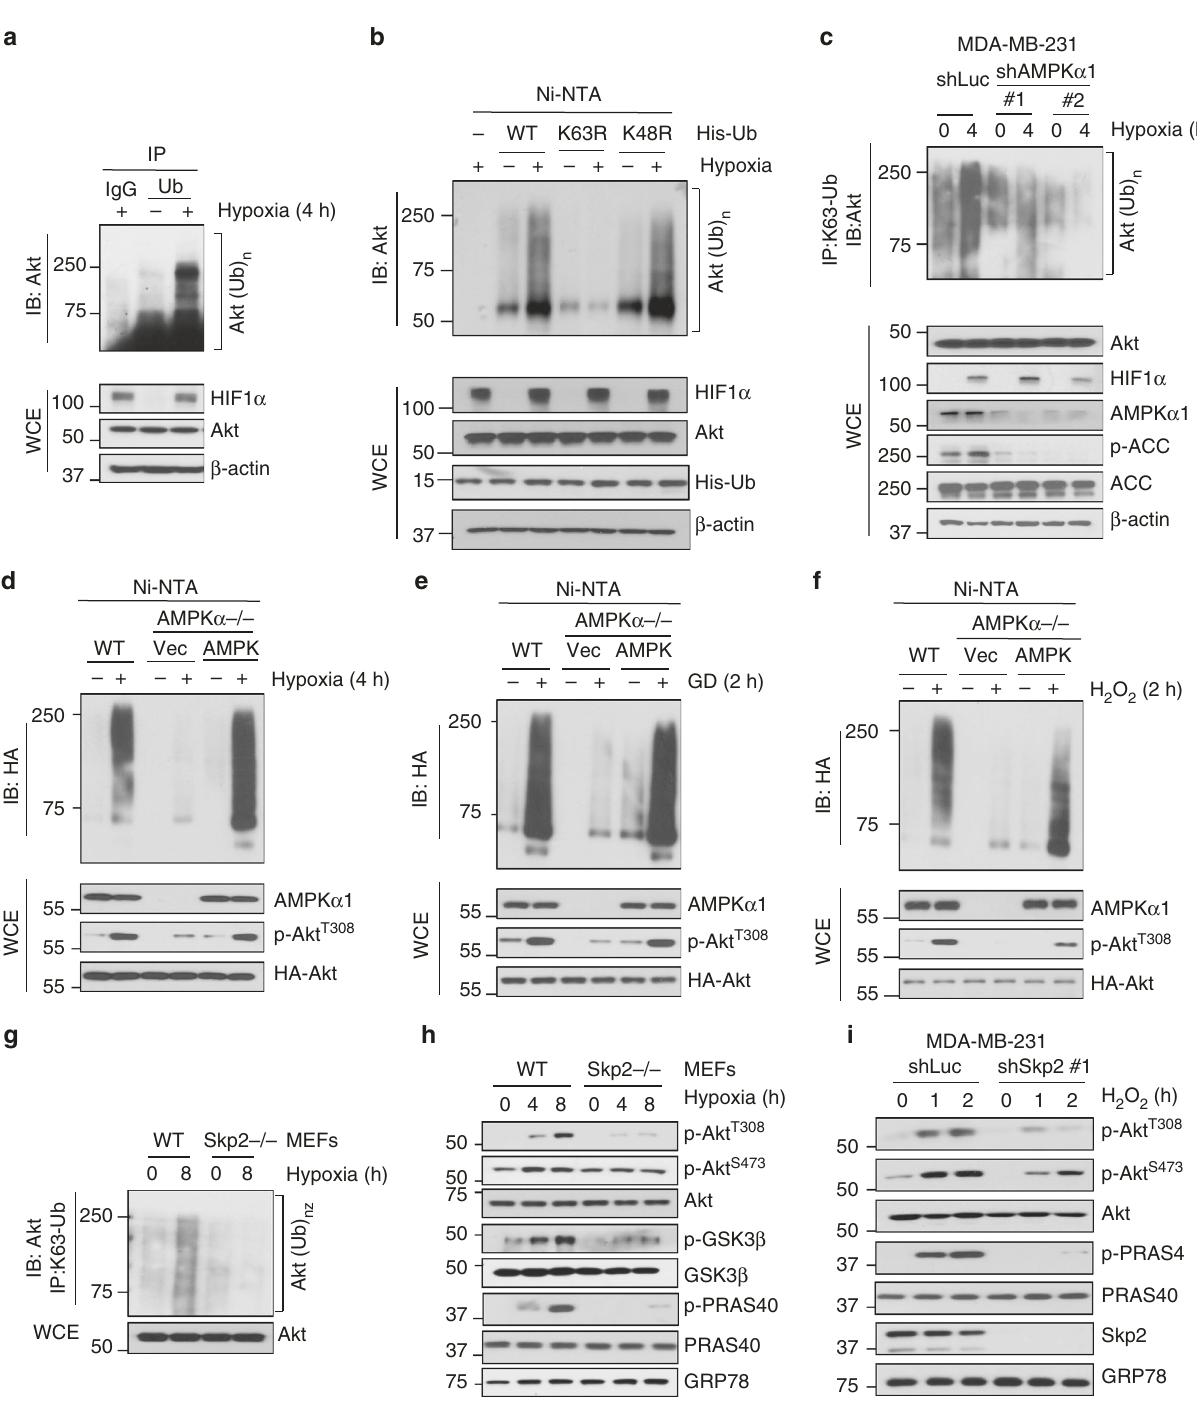
Fig. 3 Skp2 and AMPK are crucial for stress-induced Akt ubiquitination and activation. a HEK293 cells in normoxia and hypoxia were subject to immunoprecipitation with Ubiquitin antibody, followed by immunoblotting. Input is 10% of whole cell lysate. b In vivo ubiquitination assay of Akt from 293T cells transfected with WT, K63R and K48R His-Ub in response of 1% O 2 . Input is 10% of whole cell lysate. c Control (shLuc) and AMPK α 1 knockdown MDA-MB-231 cells in normoxia and hypoxia were subjected to immunoprecipitation with K63-speci fi c Ubiquitin antibody, followed by immunoblotting. Input is 10% of whole cell lysate. d – f In vivo ubiquitination assay of Akt from WT, AMPK α -/- MEFs restored with vector and WT AMPK α together with transfection of HA-Akt and His-Ub in response of hypoxia (1% O 2 ), glucose deprivation and H 2 O 2 for indicated time. Input is 10% of whole cell lysate. g WT and Skp2 -/- MEFs challenged with 1% O 2 for 8 h were subjected to immunoprecipitation with K63-speci fi c Ubiquitin antibody, followed by immunoblotting. h Immunoblotting of WT and Skp2 -/- MEFs that were challenged with 1% O 2 for 4 and 8 h. i Immunoblotting of control (shLuc) and Skp2 knockdown (#1) MDA-MB-231 cells were serum starved and treated with H 2 O 2 (100 μ M) for indicated